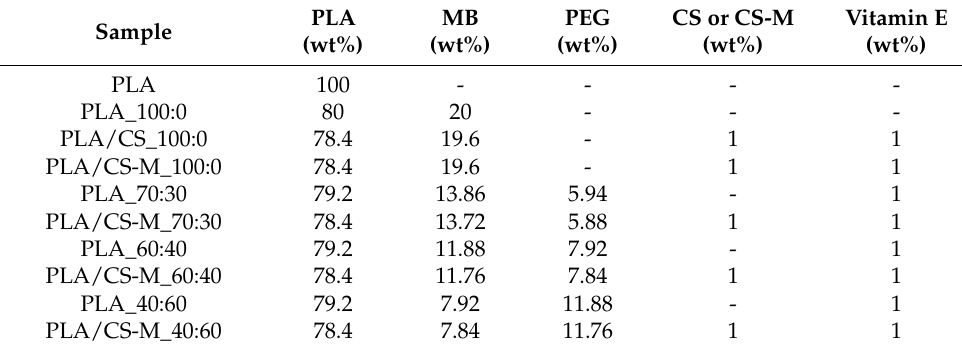
Table 1. Compositions of developed PLA-based